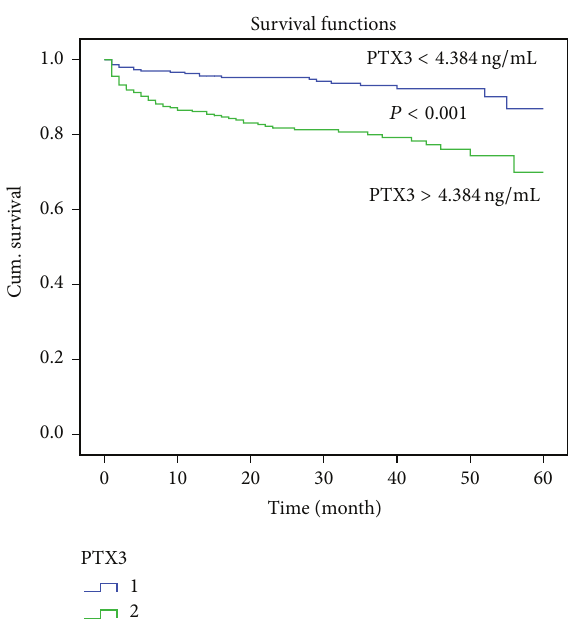
Figure 3: Kaplan-Meier curves showing incidence of cardiac event after PCI according to PTX3 (above versus below the median of 4.384 ng/mL) in patients undergoing coronary stenting. 𝑃 value is calculated by log-rank